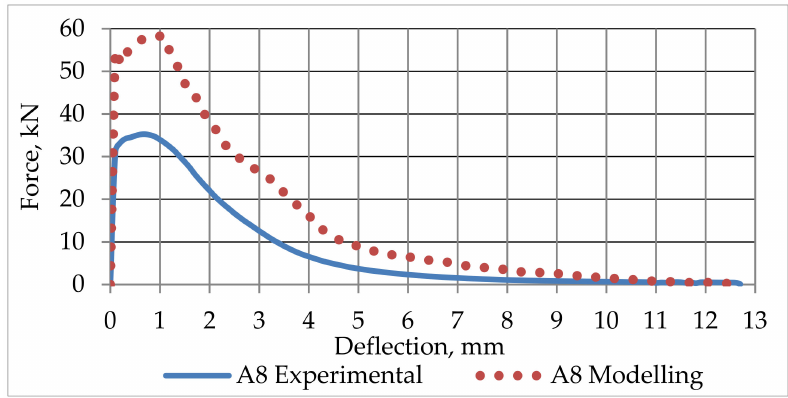
Figure 34. Experimental and modelling graphs for Group